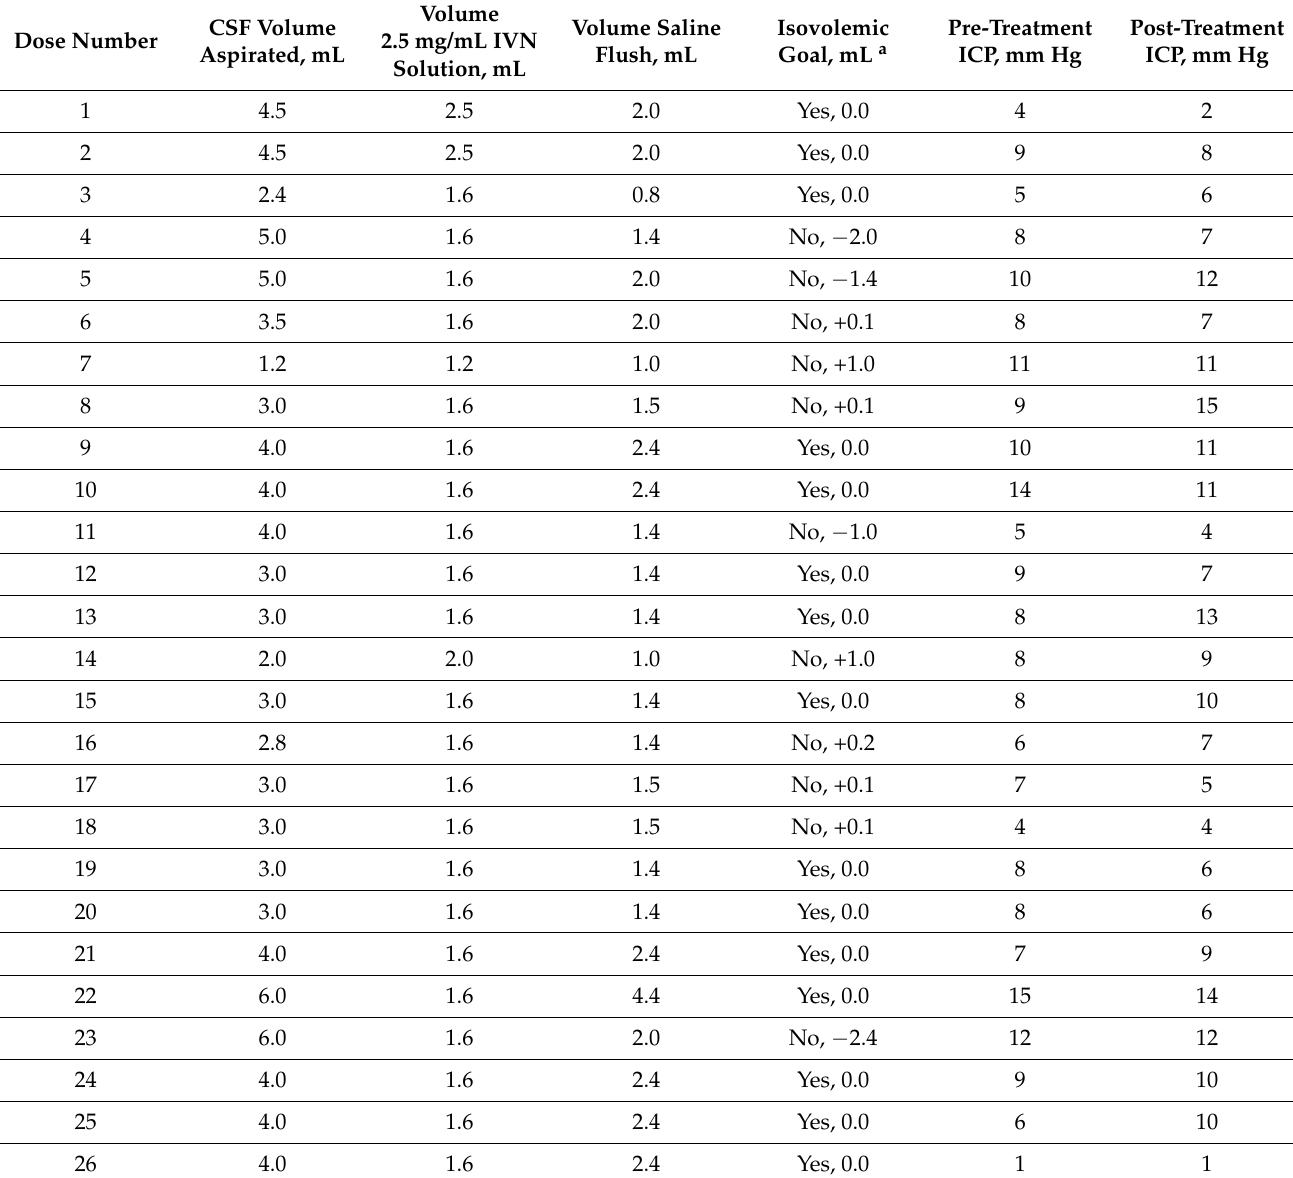
Table 1. Case 1: IVN Dosage and Related ICP